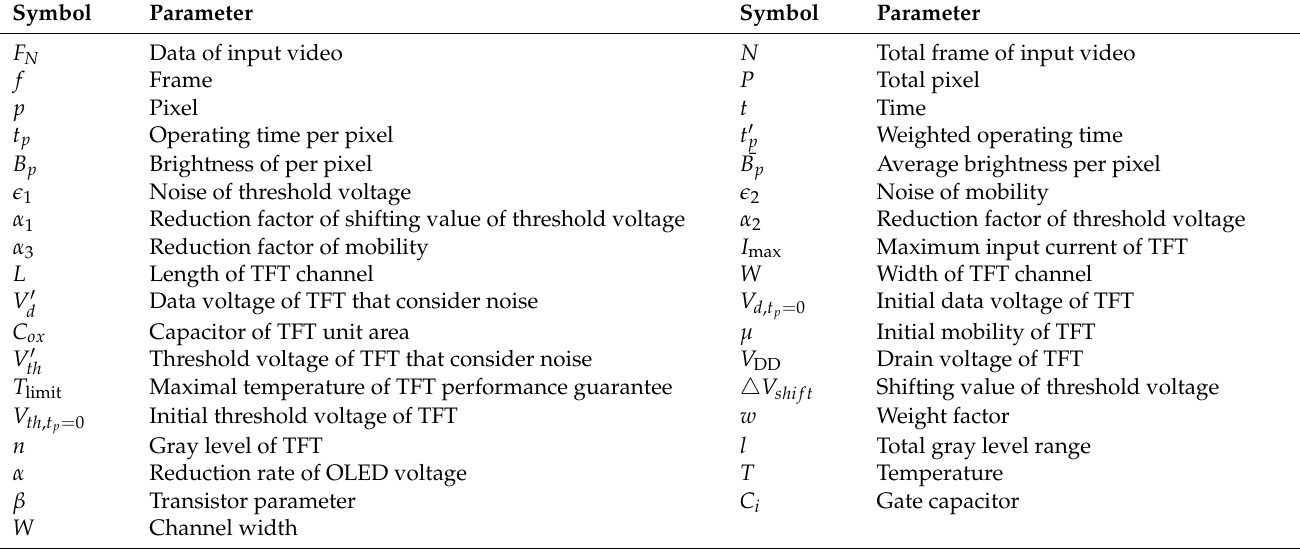
Table 2. Paper nomenclature.